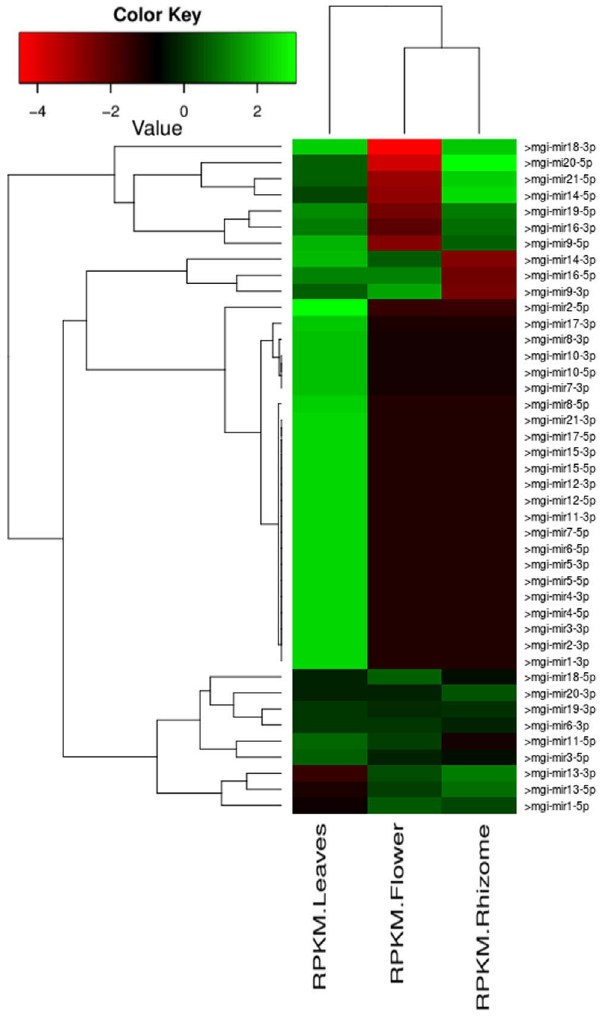
Figure 6. Heatmap based expression representation and clustering of identified miRNAs in Miscanthus .